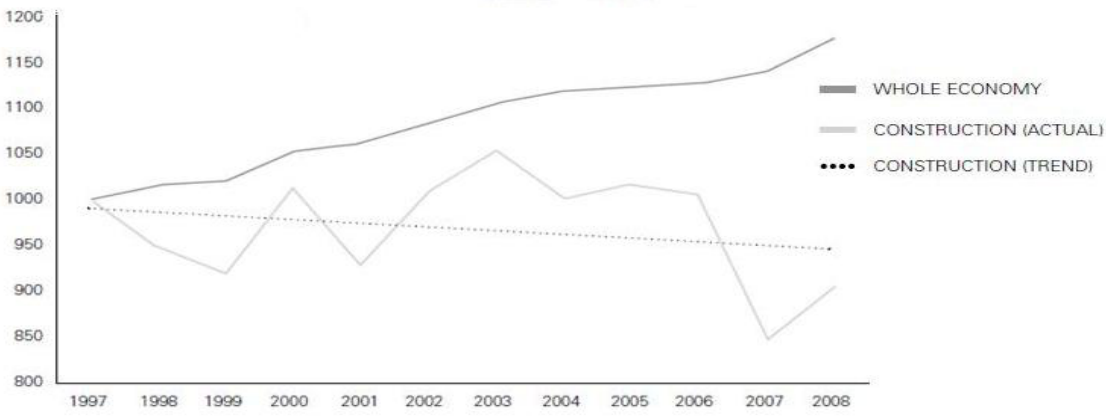
Figure 1 Labour Productivity Figure Research Aims and